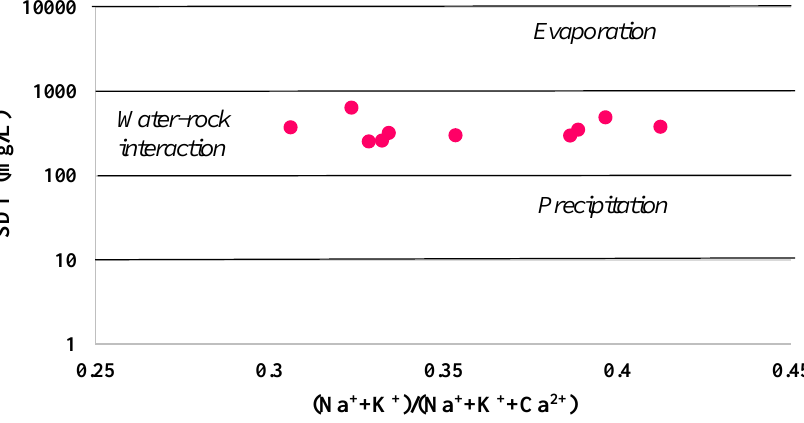
Figure 8. Gibbs diagram of the studied sites related to major cations.